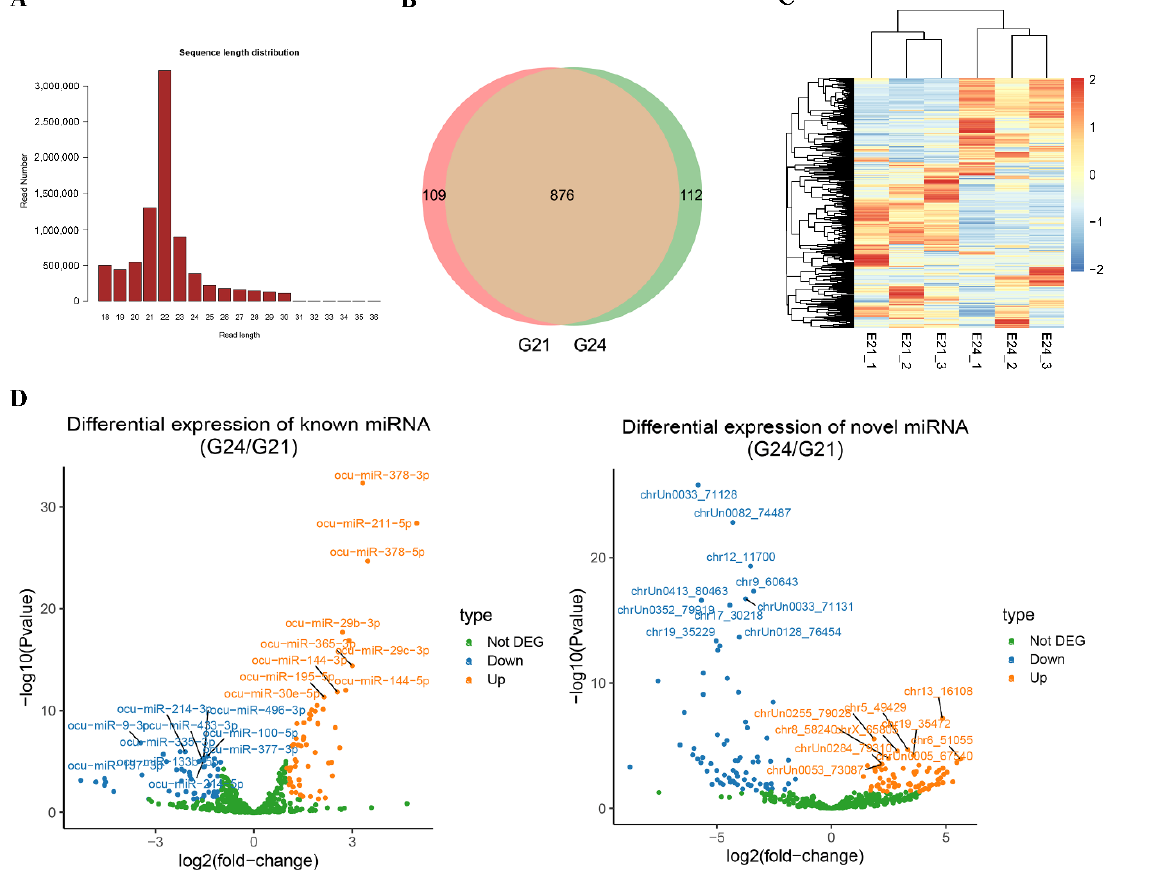
Figure 3. MiRNA-seq reveals the miRNA profiles and changes during early FBAT development. ( A ) Length distribution of reads in a representative miRNA-seq library. ( B ) Venn diagram showing the number of expressed miRNAs in G21 and G24. ( C ) Heatmap analysis and hierarchical clustering of samples using the CPM values of miRNAs. Each row shows one miRNA, and the CPM values were Z-scaled by row. The scale bar shows the Z-scaled CPM values. ( D ) Differential expression analysis of known miRNAs (left panel) and novel miRNAs (right panel). The top 10 up- and downregulated miRNAs are